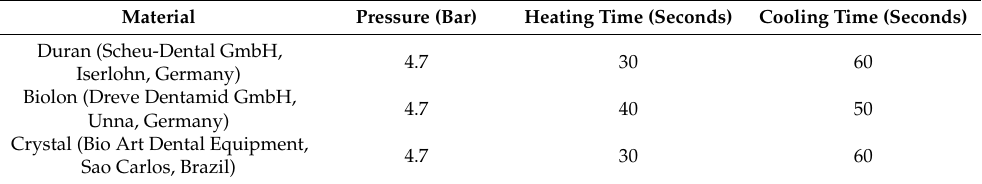
Table 1. Heating and cooling time used during the thermoforming process.